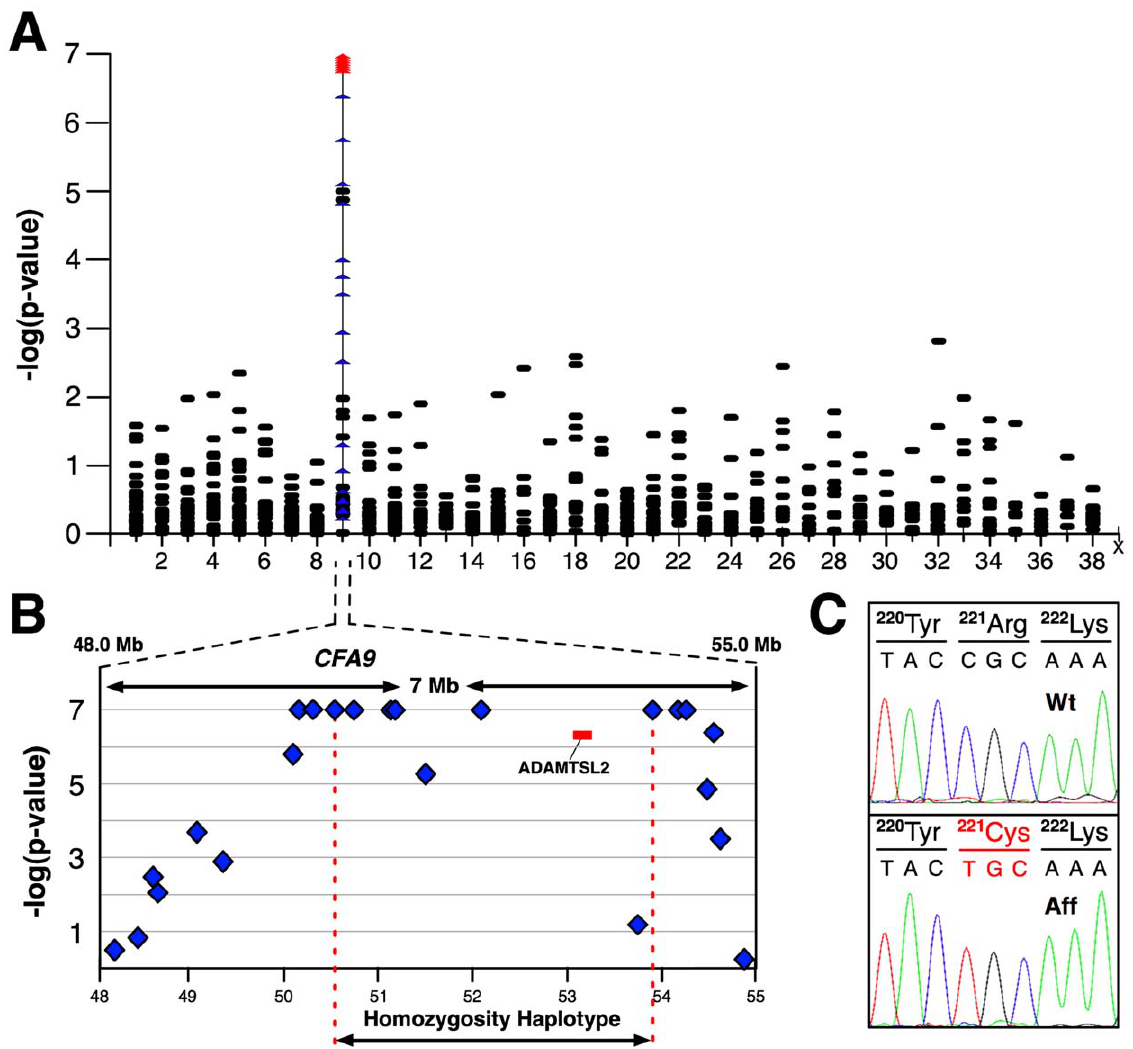
Figure 2. MLS is caused by an ADAMTSL2 mutation. ( A ) Statistical significance scores from genome-wide case-control analysis of microsatellite- based genotype data are shown. Included are results for loci used in fine-scale mapping of CFA 9 (n=23, depicted in blue). Multiple p -values estimated by permutation (10 7 iterations) were saturated for statistical significance at 10 2 7 (red). ( B ) Fine-mapping revealed a six-marker haplotype shared homozygous among all affected dogs (Table S2). The haplotype encompassed a strong candidate gene, ADAMTSL2 (depicted in red). ( C ) DNA sequence analysis identified the c.660C . T mutation. Sequence traces from PCR products amplified from genomic DNA are shown for a non-affected (Wt) and affected (Aff) Beagle. The transition (C . T) converts an arginine residue to a cysteine